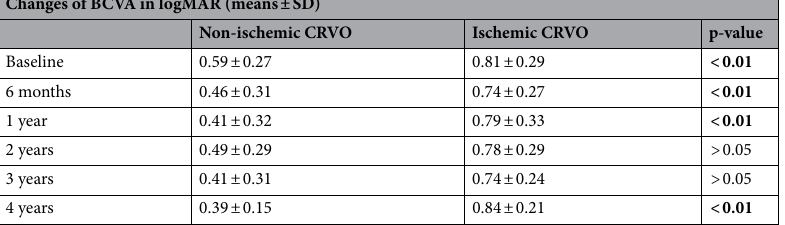
Table 5. Changes of BCVA in eyes with ischemic and non-ischemic CRVO. Significant values are in bold. SD standard deviation, BCVA best-corrected visual acuity, CRVO central retinal vein occlusion. The change in BCVA is shown in Fig. 3. BCVA improved significantly at 6 months (p = 0.001), 1 year (p = 0.001), and 2 years (p = 0.003) but not significantly after 3 years (p = 0.9) and 4 years (p = 0.9) after the first IVI.